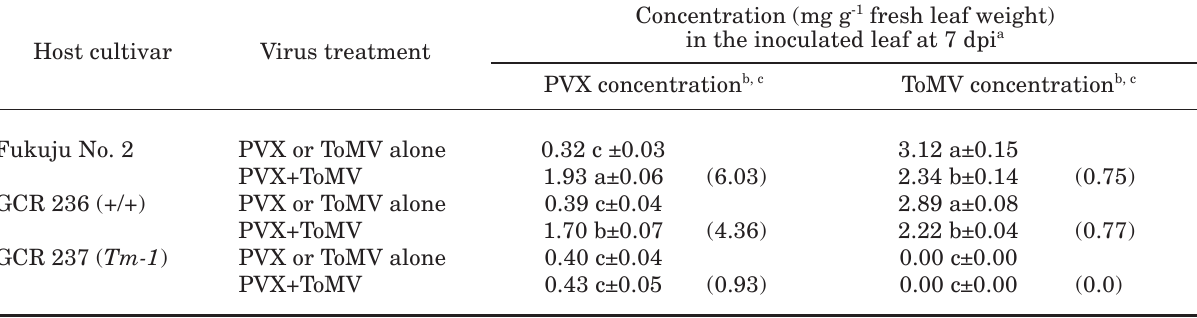
Table 2. Virus concentration, as determined by ELISA, in the systemically infected leaves of three cultivars of tomato with single and mixed infection with Potato virus X and Tomato mosaic virus.